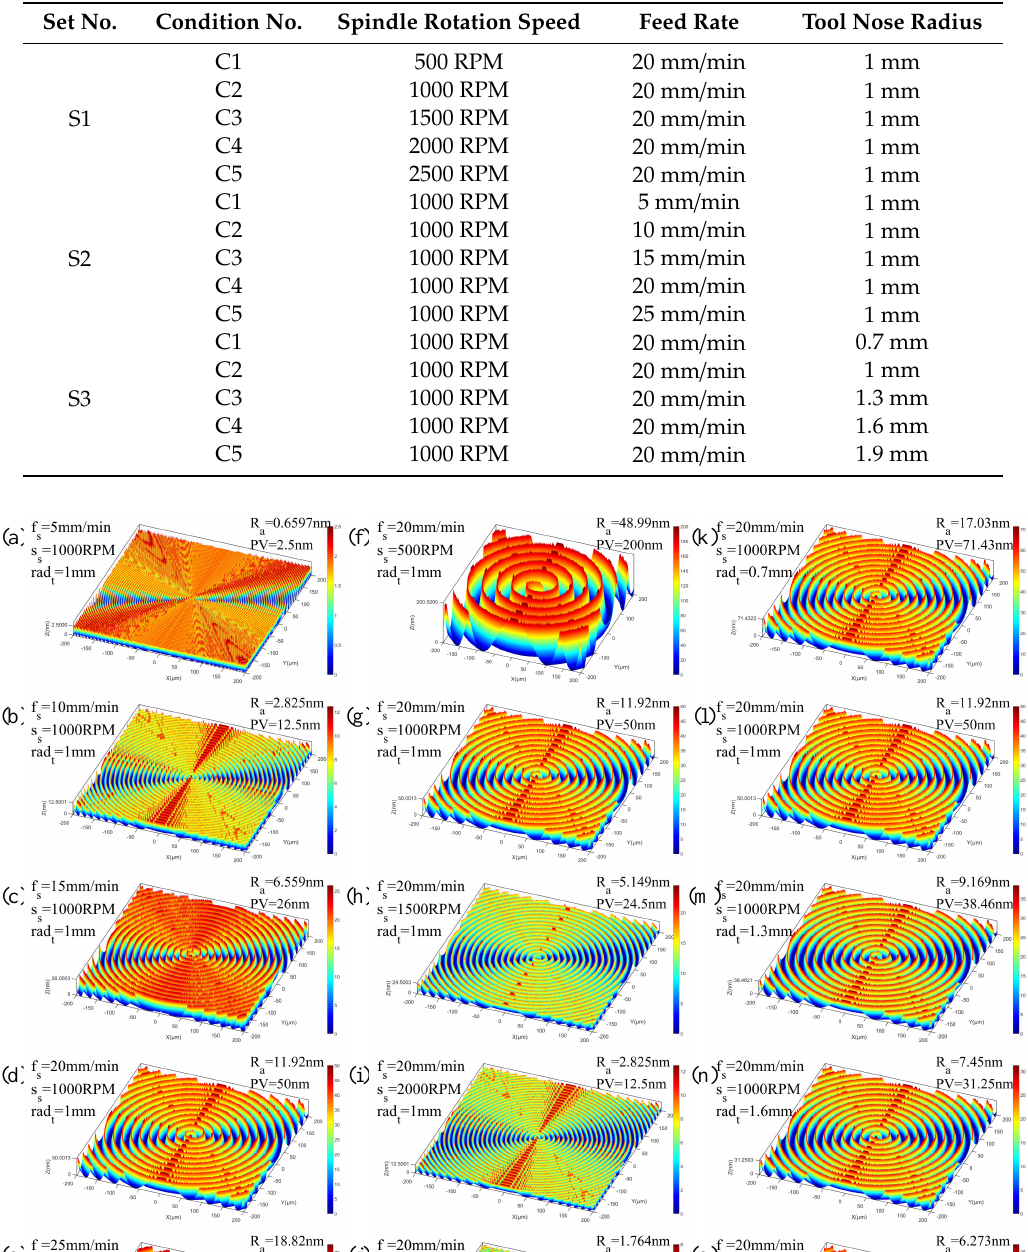
Table 1. The cutting parameters applied in the simulation.